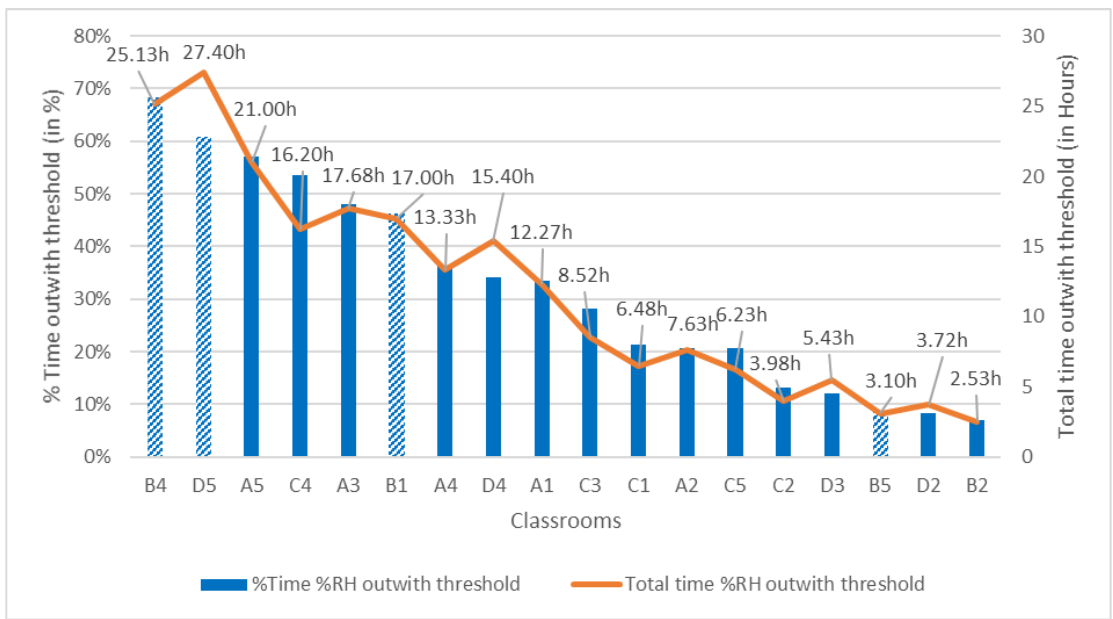
Figure 21. Indoor relative humidity in the classrooms during school hours, with classrooms B1, B4, B5, D1 and D5 having mechanical ventilation.